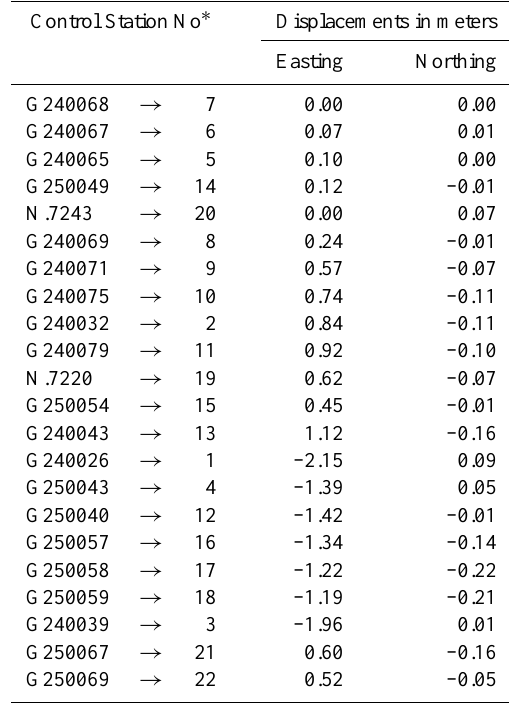
with the positioning error circles at their end ( ± 3 cm) in Fig. 5. As seen in Fig. 5, the deformation is increasing towards the fault lines, which were also observed during surface search in the field after the ˙Izmit event.